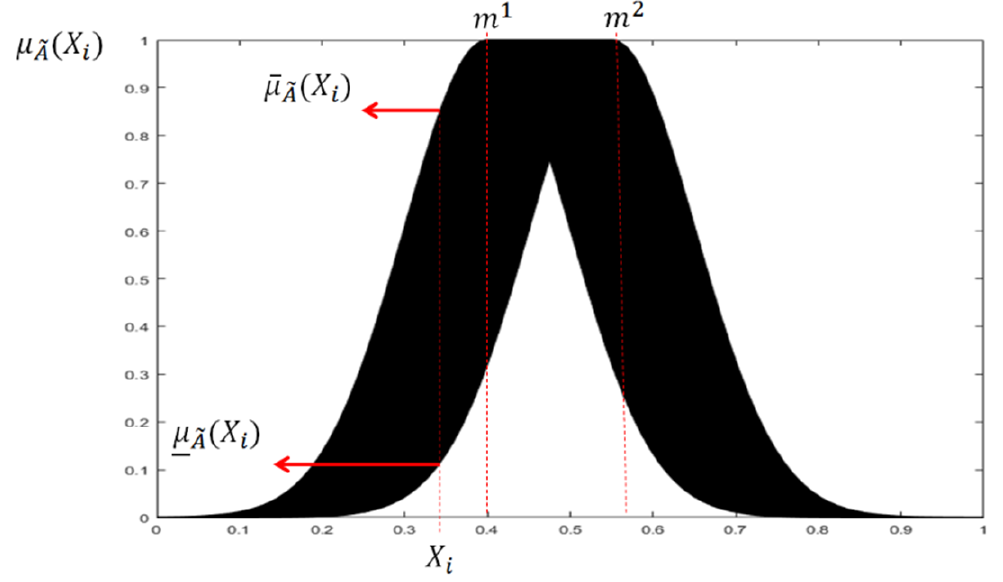
Figure 5. Interval type-2 fuzzy sets.